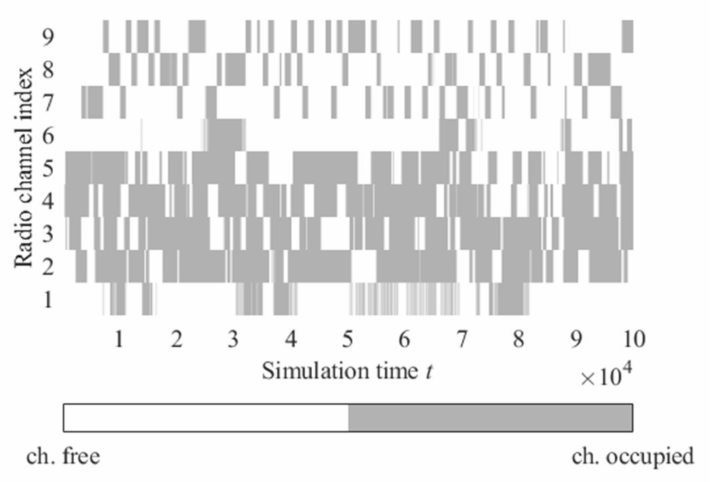
Figure 12. Aggregated sensing results for P dsystem =